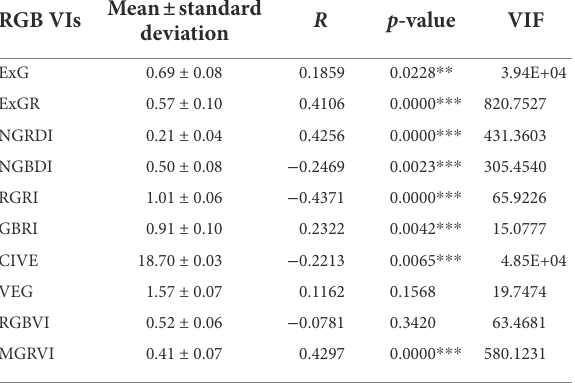
TABLE 4 VIF and correlation with SPAD in RGB VIs.